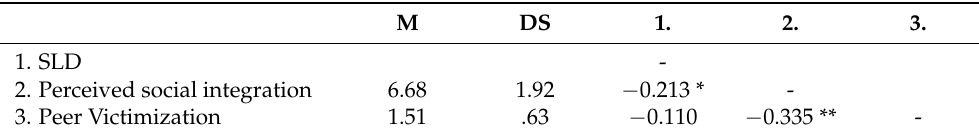
Table 1. Correlations.